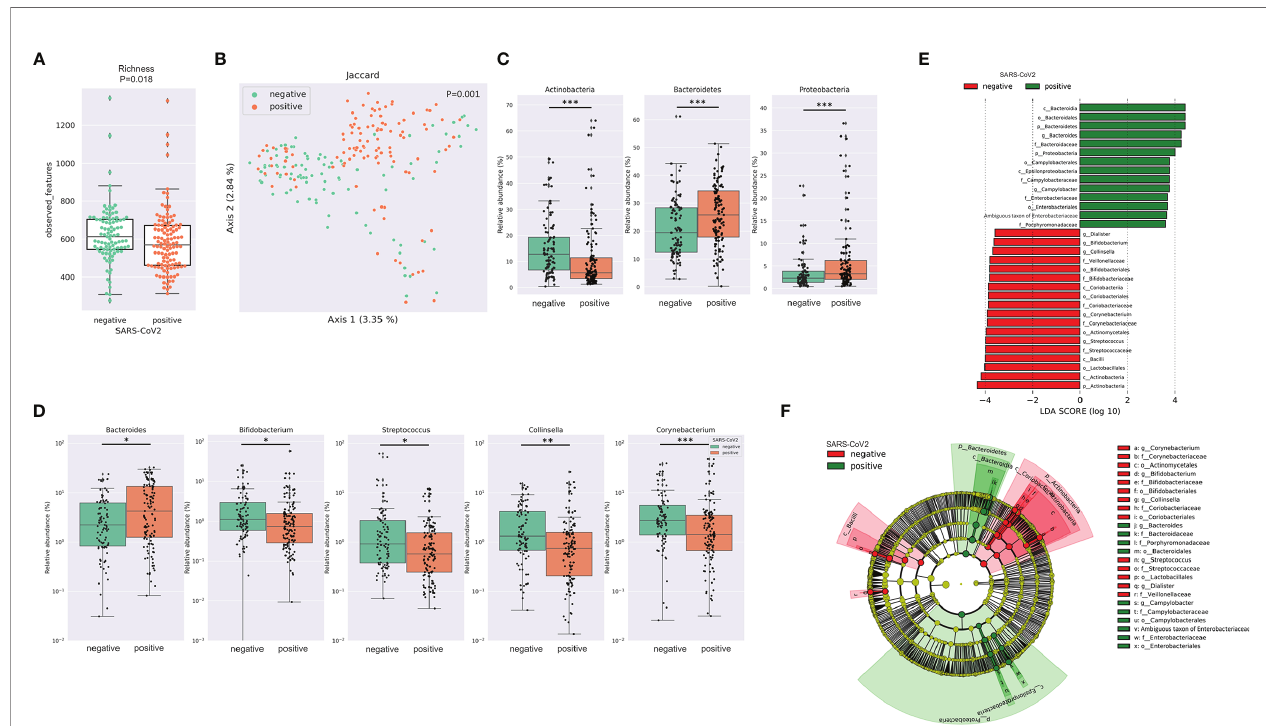
FIGURE 1 | SARS-CoV-2 infected patients exhibit distinct differences in the gut microbiome (A) Bacterial richness in SARS-CoV-2 positive and negative patients determined by observed features (amplicon sequence variants [ASV]). Kruskal-Wallis test was used to test for signi fi cant differences among groups. * FDR- P<.05; ** FDR- P<.01¸*** FDR- P<.001 (B) Principal Coordinates Analysis (PCoA) of SARS-CoV-2 positive performed with of Binary Jaccard distance matrix. PERMANOVA multivariate analysis was used to test for signi fi cant differences. (C) Differences in the relative abundance of bacterial phyla linked to SARS-CoV-2 infection. (D) Illustration of the differences in the relative abundance of bacterial genera linked to SARS-CoV-2 infection. (E) Linear discriminant effect size (LEfSe) analysis identi fi ed several bacterial taxa enriched in SARS-CoV-2 positive (green) and SARS-CoV-2 negative patients (red) (F) Cladogram reports the taxa showing different abundance values (LDA>3.5) according to LEfSe. Colors are presented in the color of the most abundant group (SARS-CoV-2 positive in green, SARS-CoV-2 negative in